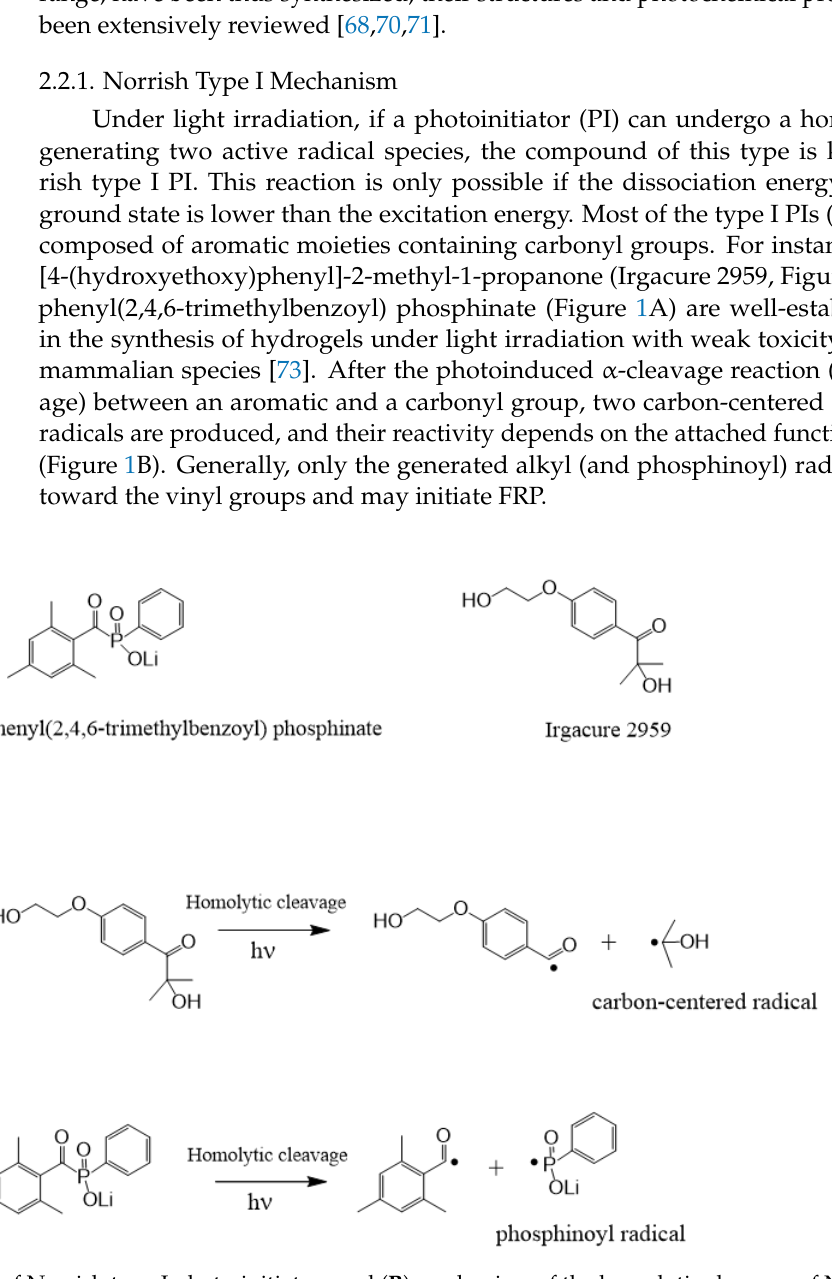
Figure 1. ( A ) Examples of Norrish type I photo-initiators and ( B ) mechanism of the homolytic cleavage of Norrish type I photo-initiators under light irradiation.